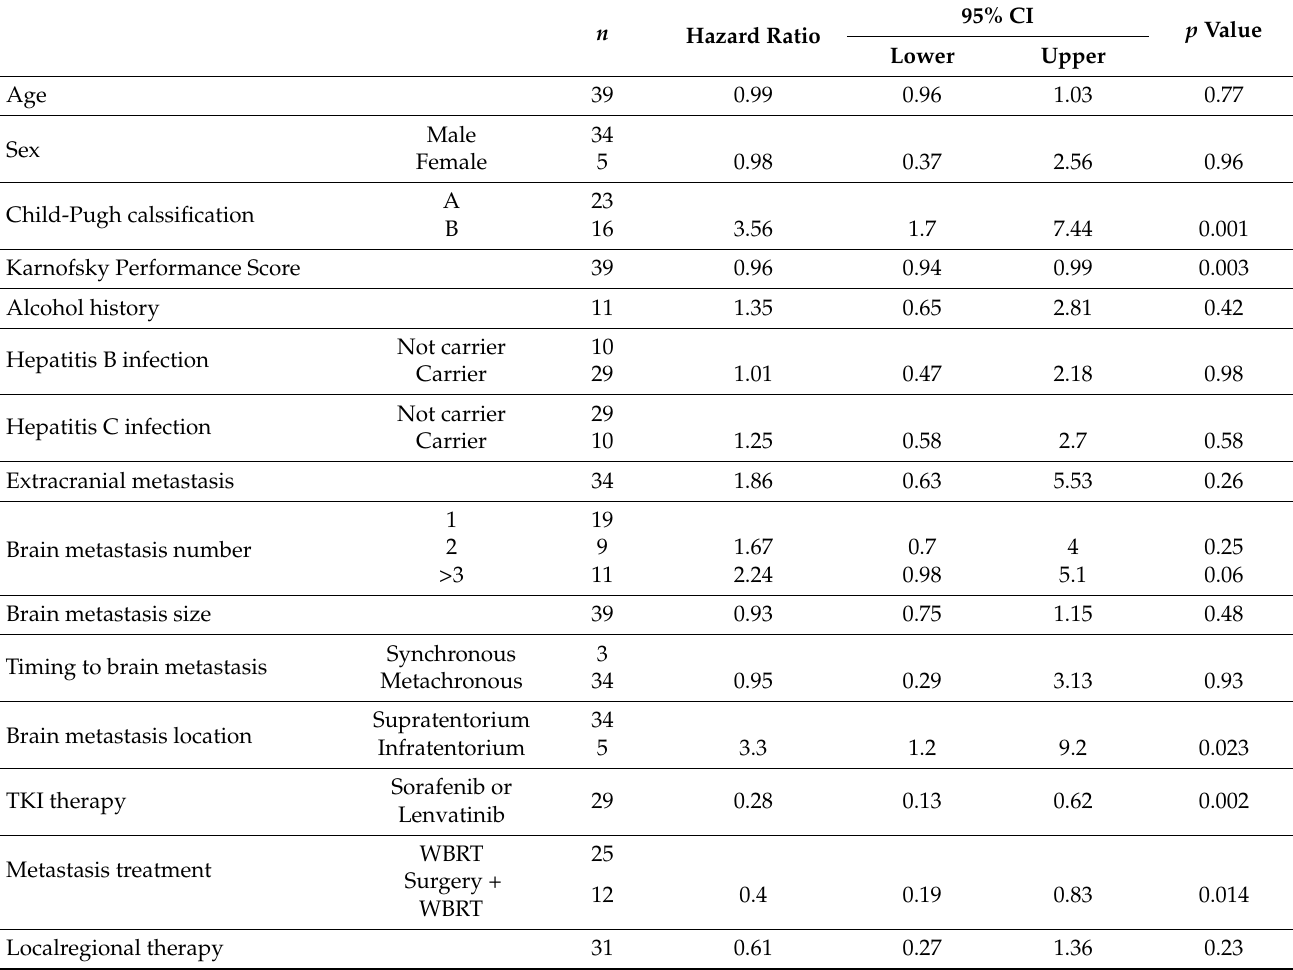
Table 3. Univariate analysis for overall survival.